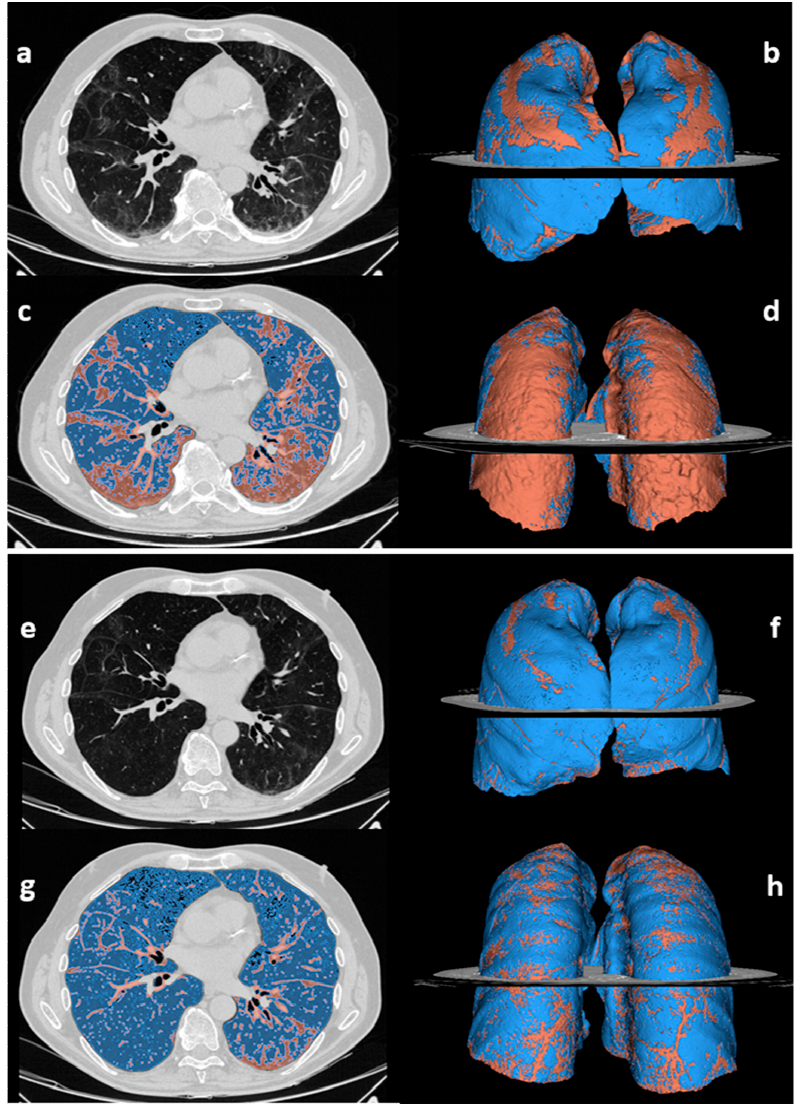
Figure 2. Abnormal lung volume quantification on chest CT scans acquired at 3 months ( a – d ) and 12 months after discharge ( e – h ) in a 70-year-old male patient who suffered from severe COVID-19. The unenhanced chest CT scans ( a , e ) are displayed alongside the pertinent segmentations of residual lung abnormalities (red) and normally aerated lung (blue) performed by 3D Slicer software ( c , g ), and the related 3D anterior ( b , f ) and posterior ( d , h ) volumetric representations. The case is representative of the subgroup of patients with improved but still abnormal chest CT findings ( group 3 ). The percentage of abnormal lung volume decreased over time, from 33% at three months ( b , d ) to 13% at 12 months after discharge ( f , h ). The dorsal segments are the most impacted by residual CT findings at 12 months.